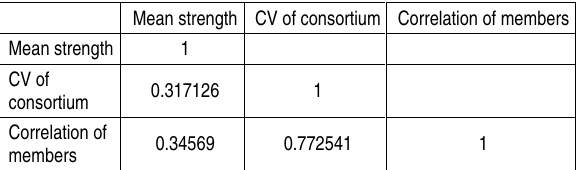
Table 45. Summary of